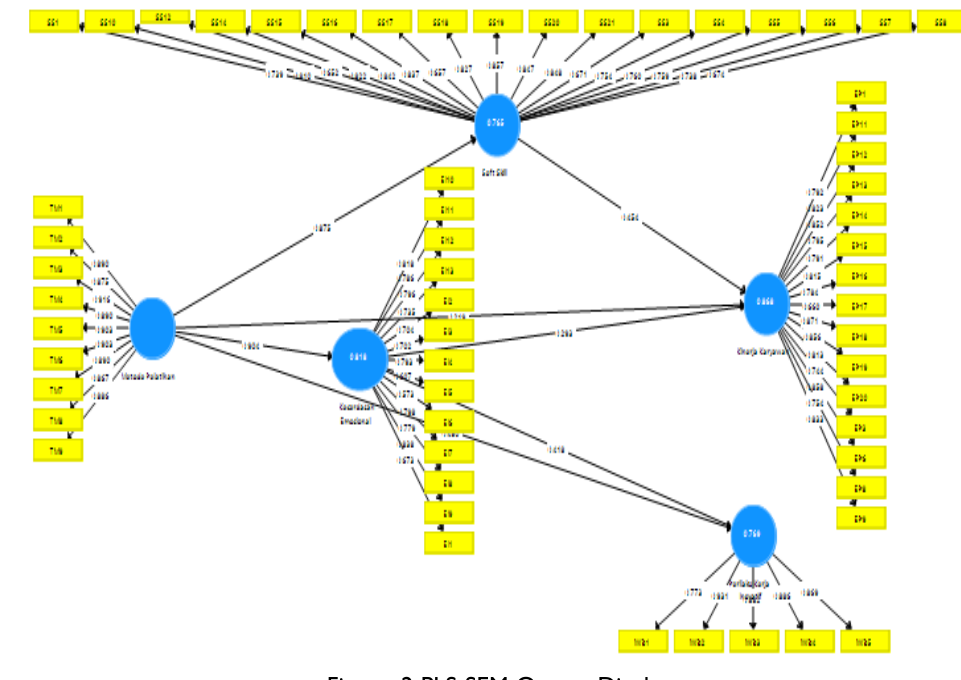
Figure. 2 PLS-SEM Output